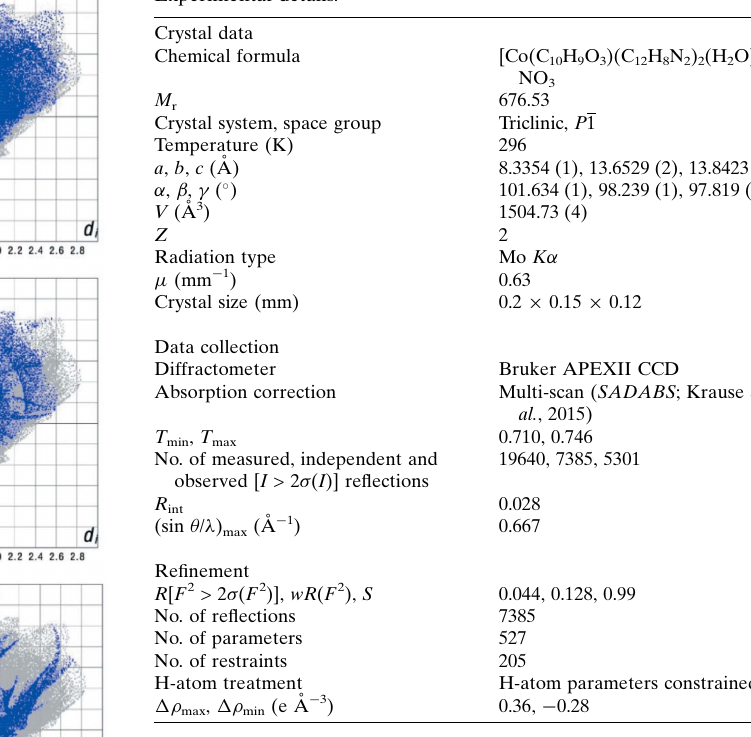
Table 4 Experimental details.